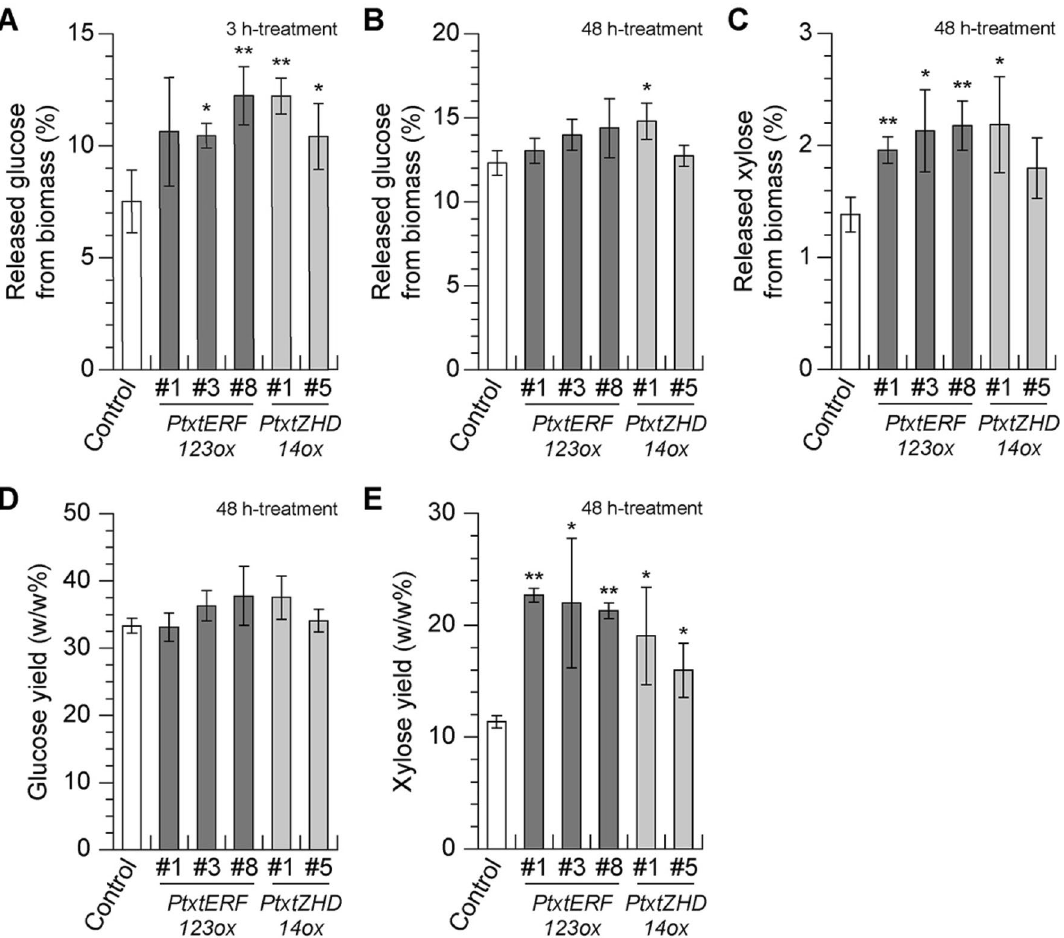
Figure 3. The enzymatic saccharification of Pt × tERF123ox, and Pt × t ZHD14ox lines grown in the soil, in comparison to the controls (GFP-TUA6). Released glucose ( A , B ) and xylose ( C ) amounts from biomass (wt/ wt %) after 3 h ( A ) or 48 h ( B , C )-treatments with cellulase cocktail. Glucose and xylose yields ( D , E ) calculated based on a total of glucan (non-crystalline glucan and crystalline glucan) and xylan measured in Table 2. Data are shown as mean ± standard deviations of biological triplicates. Single and double asterisk(s) indicate P value < 0.05 and < 0.01, respectively in Student’s t - test when compared with the control plants.